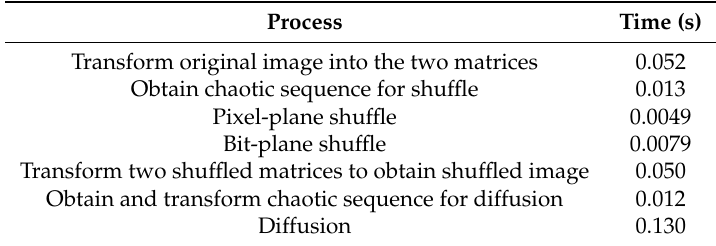
Table 8. Time consumed by different